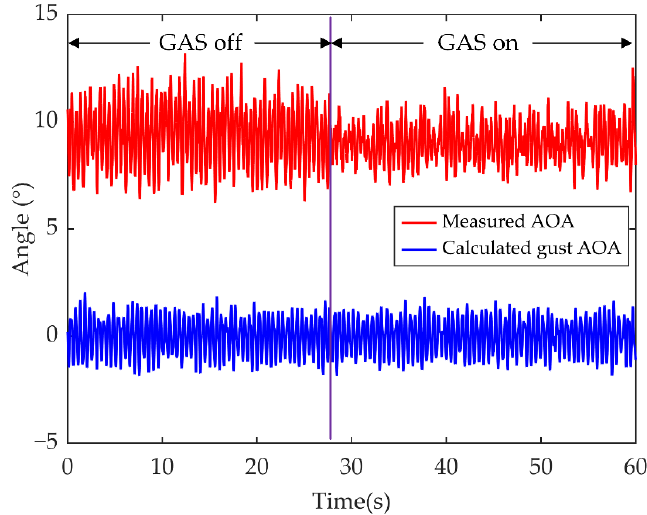
Figure 22. Calculated gust AOA of gust alleviation wind tunnel test.